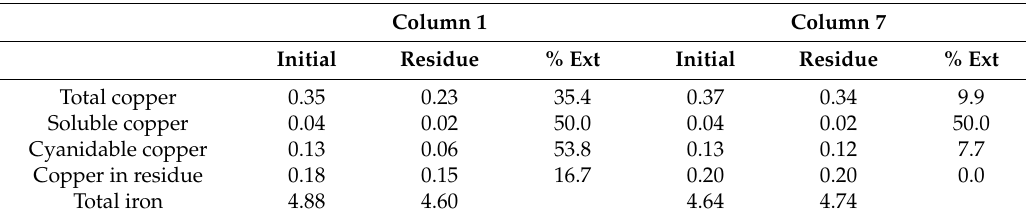
Table 9. Copper extractions in column 1 (32.9 °C, 0.6 kg H 2 SO 4 /50 kg of ore, 0 NaCl, 0 FeSO 4 ) and